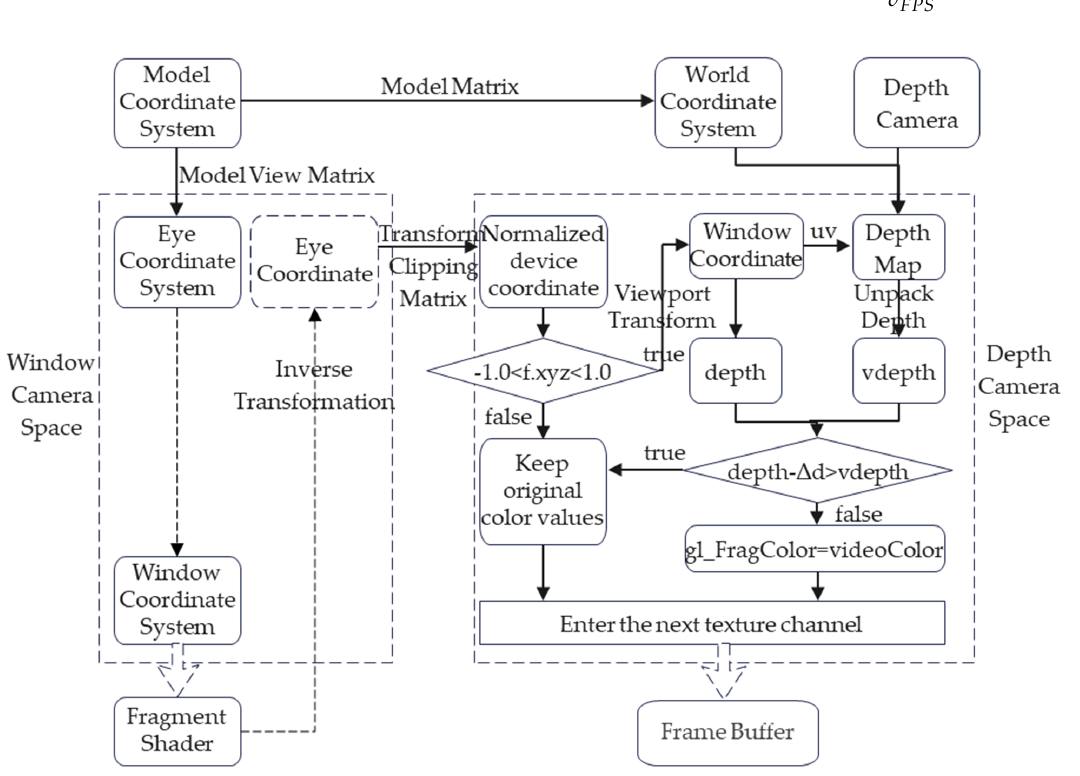
Figure 5. Flow chart of projection texture mapping for a single video image.